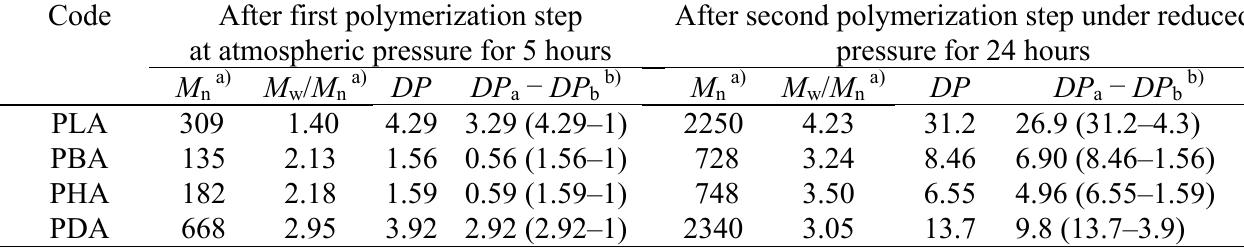
Table 1. Number-average molecular weight ( M and degree of polymerization ( DP ) of 2-hydroxyalkanoic acid homopolymers after the first polymerization step at atmospheric pressure for 5 h and subsequent second polymerization for 24 h under reduced